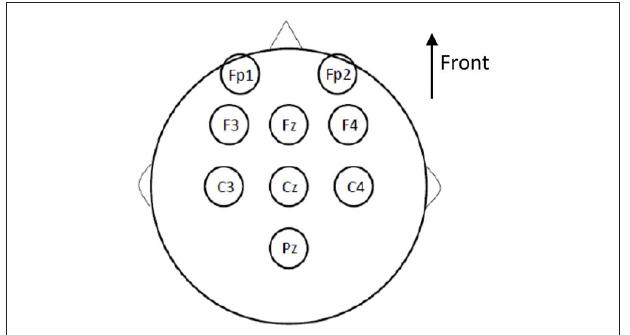
FIGURE 3 | Cortical sites of gustatory evoked potentials (GEP) recording according to the international 10–20 system (conventional EEG recording). Nine sites were taken into account: Pz, Cz, C3, C4, and Fz for measurements of the primary gustatory cortex; and F3, F4, Fp1, and Fp2 for measurements of the secondary gustatory cortex. The electrodes were referenced against linked earlobes. The ground electrode was placed on the forehead.